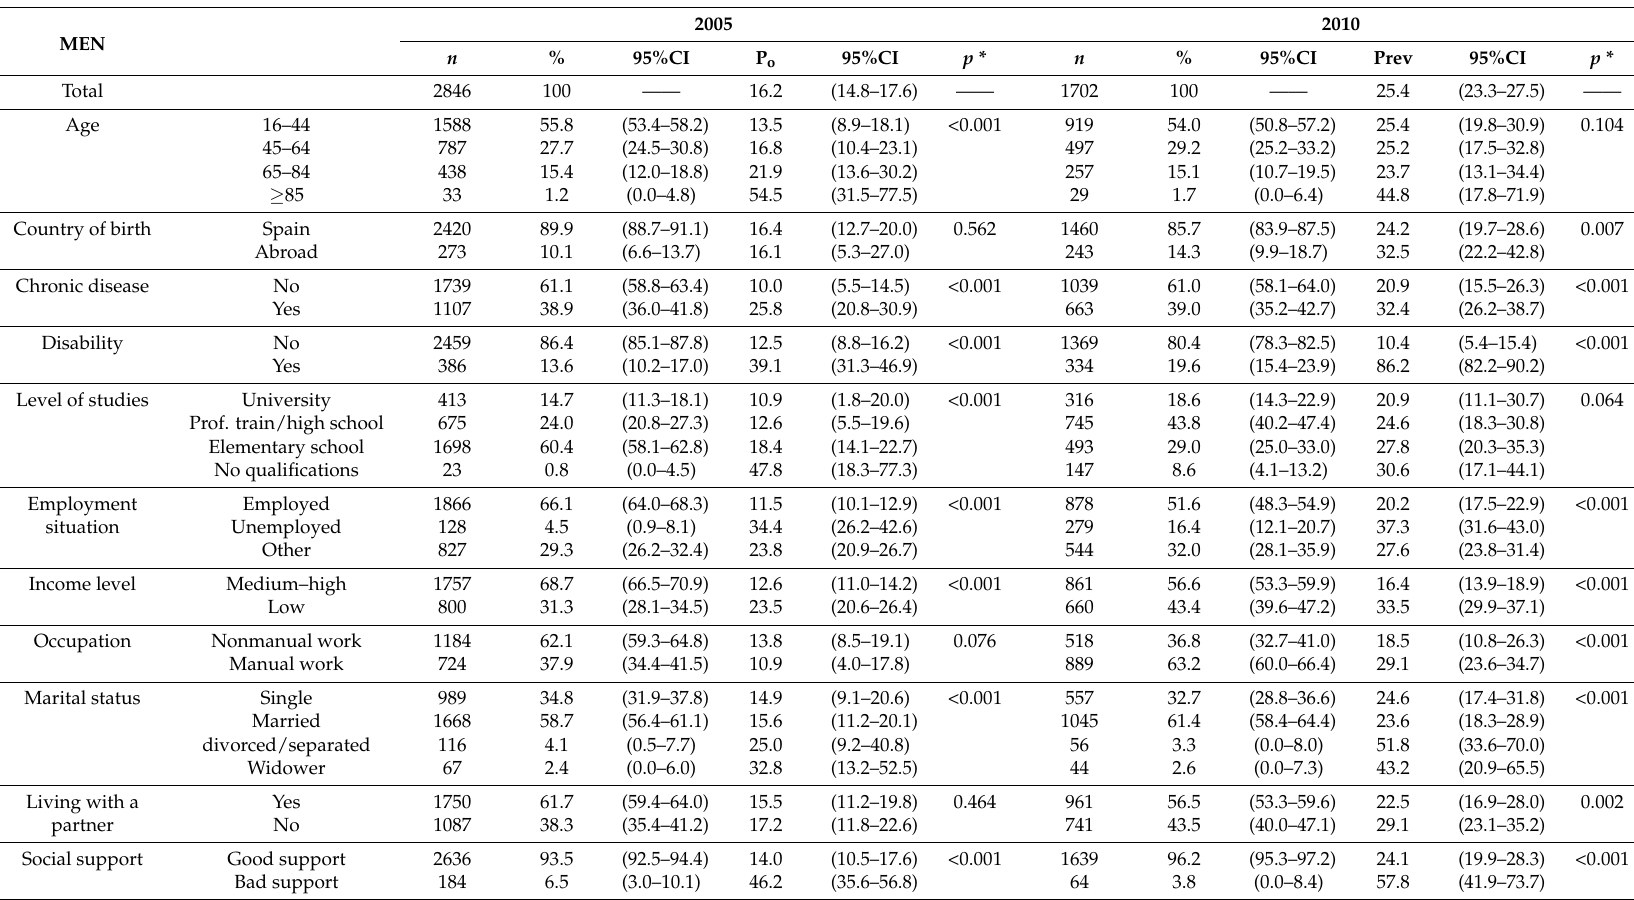
Table 1. Frequencies ( n ), percentages (%) of population distribution, and observed prevalence (P o ) × 100 and 95% confidence interval (95%CI) of the risk of poor mental health, according to categories of explanatory variables and according to the year of the survey.